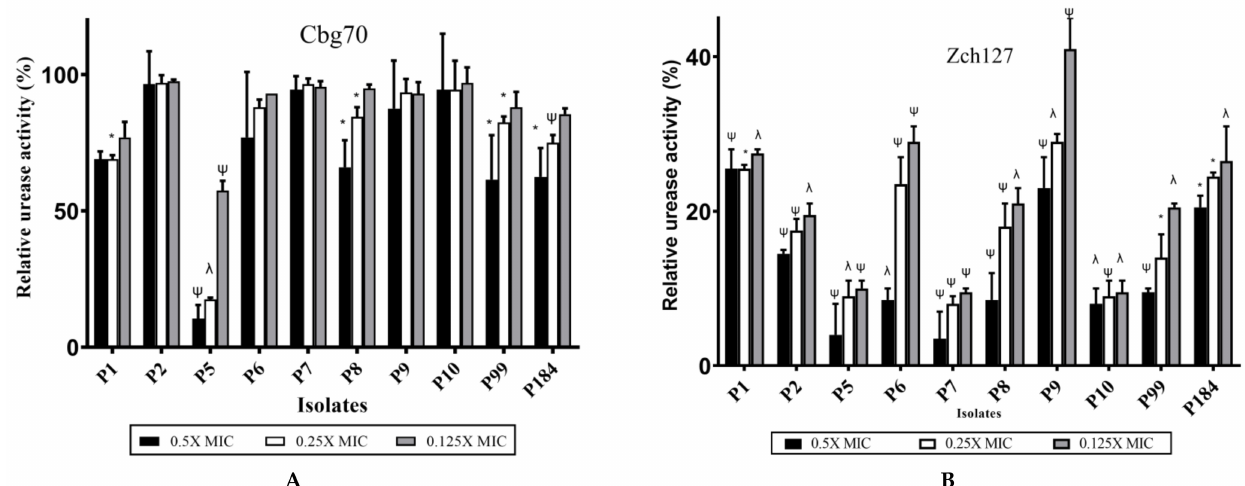
Figure 5. Effect of crude supernatant extracts of Cbg70 and Zch127 on urease activity. The relative urease activity of the P. mirabilis isolates in the presence of sub-MICs of extracts: ( A ) Cbg70; and ( B ) Zch127, at different concentrations (0.5X, 0.25X and 0.125X MIC). The values were obtained in the absence of extract after 3 h of incubation were set at 100 %, and all other values were expressed relative to this value. The data represents the means of three independent experiments and error bars show standard error of the mean. Statistical difference was determined by student’s t -test * p < 0.05; ψ p < 0.01; λ p < 0.001 compared with DMSO